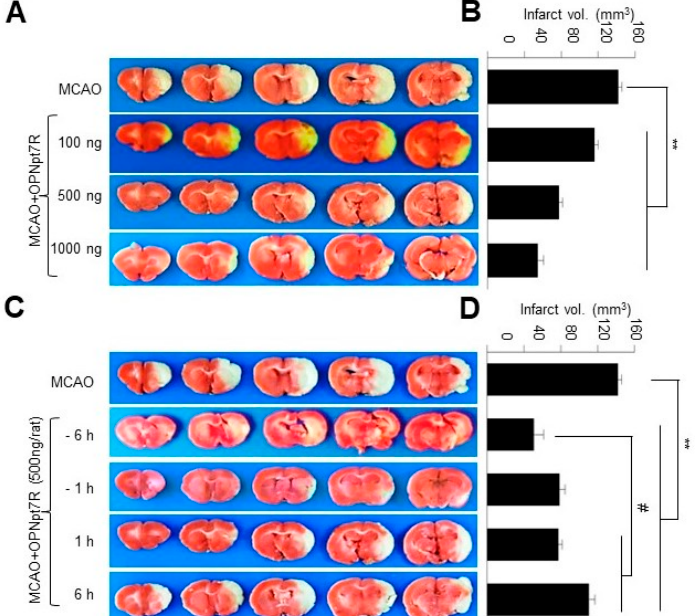
Figure 2. Reduction in infarct volume by intranasally administered OPNpt7R at various concentra- tions and times; OPNpt7R (100, 500, or 1000 ng) was administered intranasally at 1 h post-MCAO ( A , B ) and OPNpt7R (500 ng) was administered intranasally at 6 or 1 h prior to- or 1 or 6 h post- MCAO (60 min) ( C , D ). TTC staining was performed at 2 days post-MCAO. Representative images of infarctions are shown ( A , C ) and mean infarction volumes are presented as the mean ± SEM ( B , D ). Sham, sham-operated rats ( n = 3); MCAO, PBS-treated MCAO control ( n = 4); OPNpt7R, OPNpt7R- treated MCAO rats ( n = 28). ** p < 0.01 vs. PBS-treated MCAO control, # p < 0.05, between indicated groups.